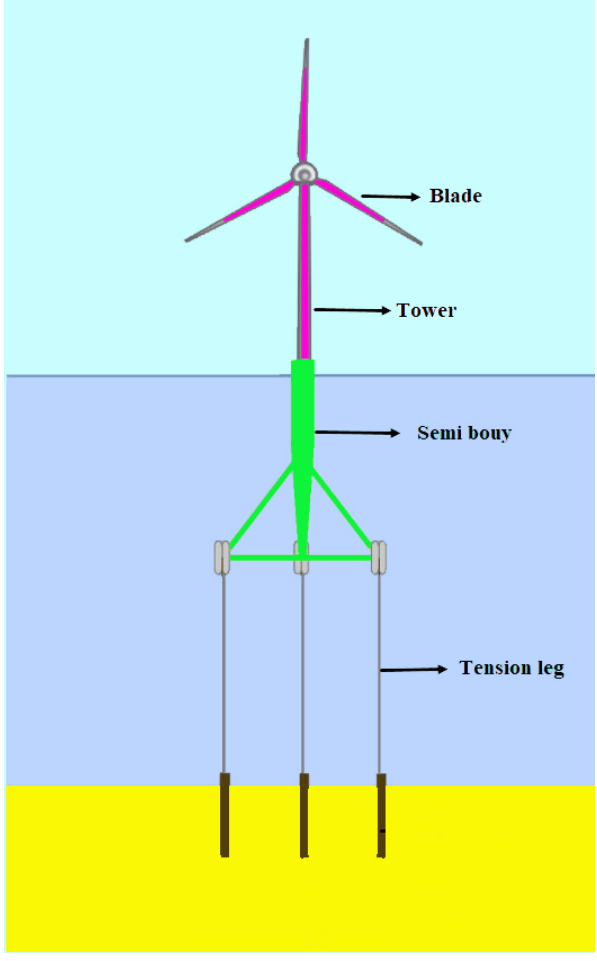
Figure 1. Schematic representation of tension leg platform